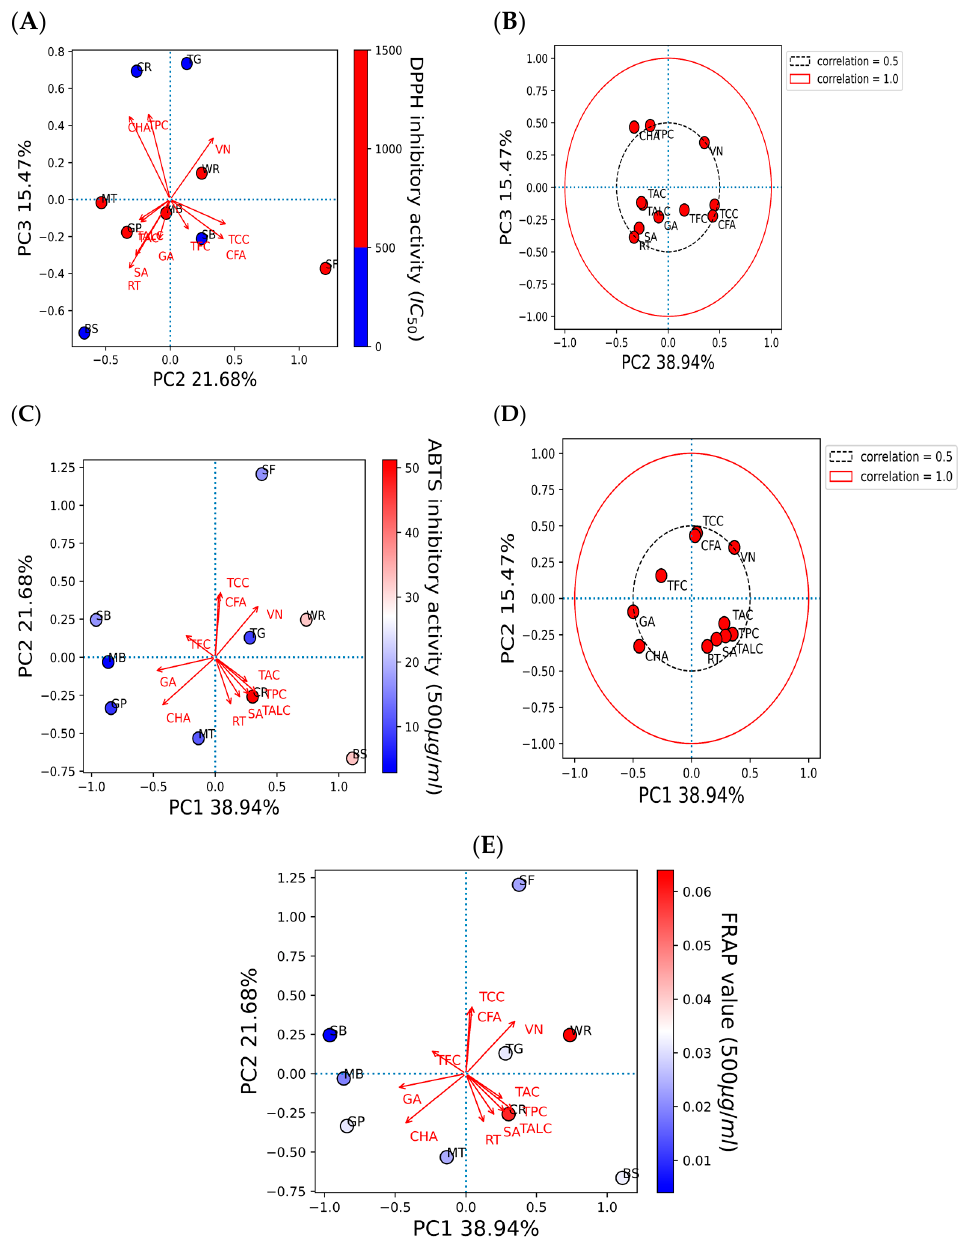
Figure 5. Principal component analysis (PCA) of bioactive compounds in sprout extracts and their antioxidant activities ( A , C , E ). Score plots between the antioxidant capacity based on DPPH, ABTS, and FRAP assays of SF, MT, BS, TG, MB, SB, WR, CR, and GP ( B , D ). Loading plots of bioactive compounds detected in the extracts. Red dot indicates the bioactive compounds. Dashed and solid line indicates correlation >0.5 and 1, respectively. Blue dot in ( A ) indicates the strongest DPPH inhibitory activities. Red dots in ( C , E ) indicate the strongest ABTS inhibitory activities and ferric-reducing antioxidant power, respectively. Abbreviation: TCC = total chlorophyll content, TPC = total phenolic content, TAC = total anthocyanin content, TALC = total alkaloid content, TFC = total flavonoid content, GA = gallic acid, SA = syringic acid, CHA = chlorogenic acid, CFA = caffeic acid, VN = vanillin, RT = rutin, DPPH = DPPH radical scavenging activity, FRAP = ferric-reducing antioxidant power, ABTS = ABTS radical scavenging activity.